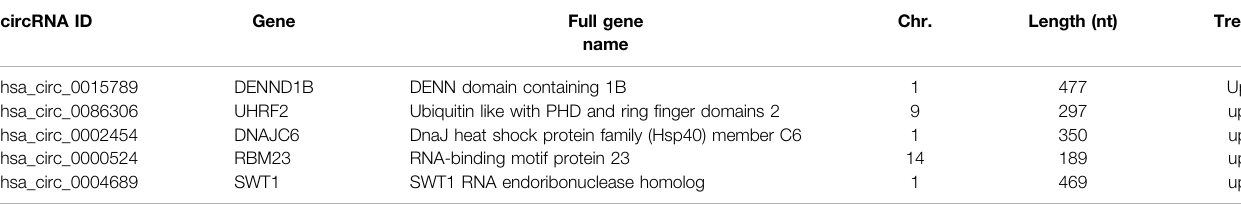
TABLE 1 | Final circRNA markers for the age prediction models. Description of their features, originated gene name, and tendency during aging. circRNA ID